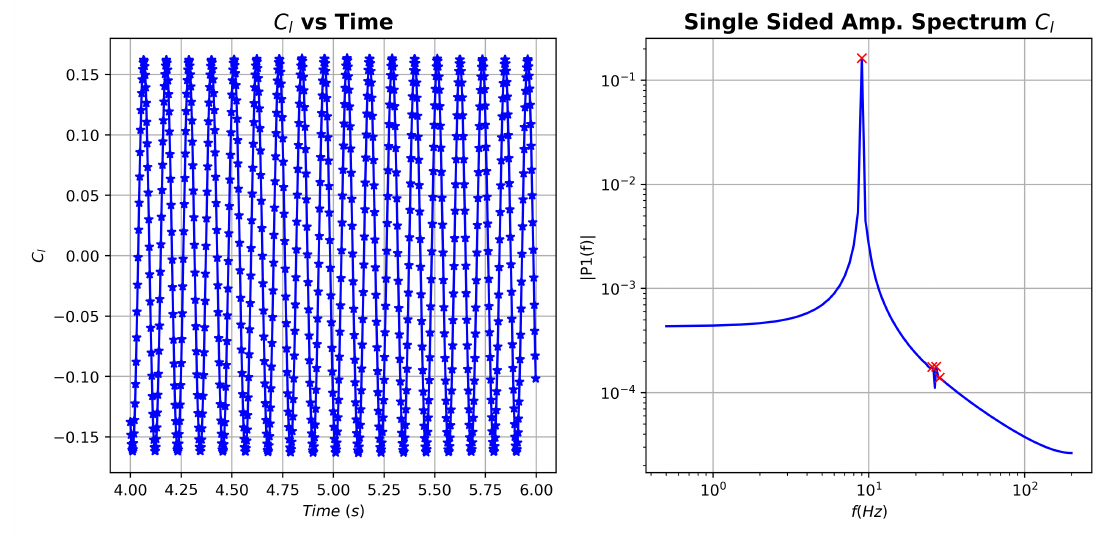
Figure 6. Re D = 60 cylinder flow: C l vs time and associated fast Fourier transform ( FFT )